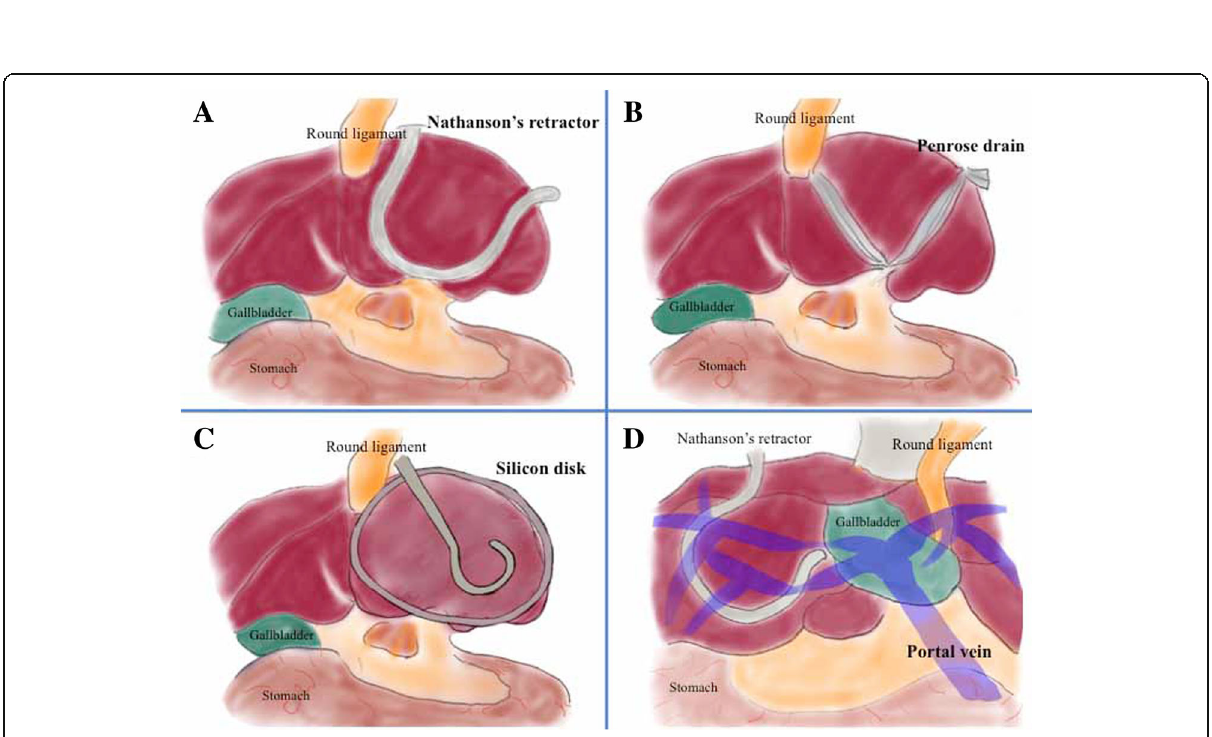
Fig. 4 Methods of retracting the left liver lobe. The Nathanson liver retractor method ( a ), Penrose method ( b ), and silicon disk method ( c ) are shown. In our case ( d ), the first bifurcation of the portal vein was behind the gallbladder; therefore, the Nathanson retractor compressed the posterior and inferior branches of the portal